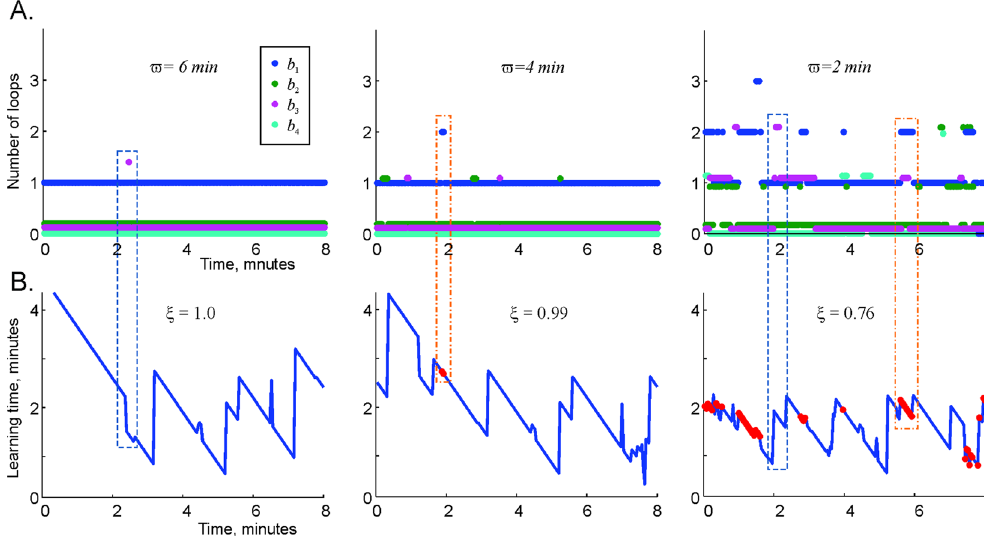
Figure 5. Stability of large-scale topological information. ( A ) The low-dimensional Betti numbers b 1 , b 2 , b 3 as a function of discrete time, computed for three coactivity integration windows, ϖ = 6 minutes, ϖ = 4 minutes and = 1, remains stable at all times and is therefore not shown. At ϖ = 2 minutes. The 0th Betti number, b 0 sufficiently large coactivity windows, ϖ ∼ − 4 6 minutes, the topological fluctuations become suppressed and the large-scale topological information remains stable, even though the characteristic lifetime of a maximal simplex in the coactivity complex ϖ  is about 10 secs (Fig. 4C). As the integration window narrows, the topological fluctuations intensify (Suppl. Fig. 2). ( B ) The variation in the time required to extract the topological information increases as the coactivity integration window shrinks. At ϖ = 6 min, there are no failing points. Notice that the starting learning time corresponds to the T min value computed for the “perennial” case ϖ = ∞ , illustrated on (Fig. 1B). As the memory window shrinks to ϖ = 4 min, the topological mapping fails in only 1% of the cases—just one point over 8 minute interval, when a spurious 1 D loop appears. At ϖ = 2 min, the complex ξ = 0.76). The ϖ  fails to produce the correct topological information in 24% of the cases (convergence score failing moments are marked by red dots. Here we compute the most conservative estimate for the learning time T min to be the time required to establish the correct topology only in the dimensions that may contain physical obstructions, 0 D and 1 D . Therefore, the points where T min diverges are marked by appearances of spurious 1 D loops (encapsulated into red dashed boxes across panels). The points where the learning time rapidly changes are often accompanied by the appearance or disappearance of higher dimensional topological loops (blue dashed